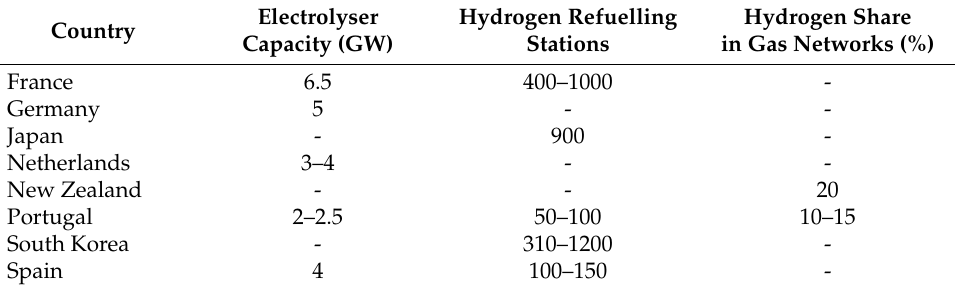
Table 1. Hydrogen related targets in selected countries for 2030. Data collected from national hydrogen roadmaps. Electrolyser Country Capacity